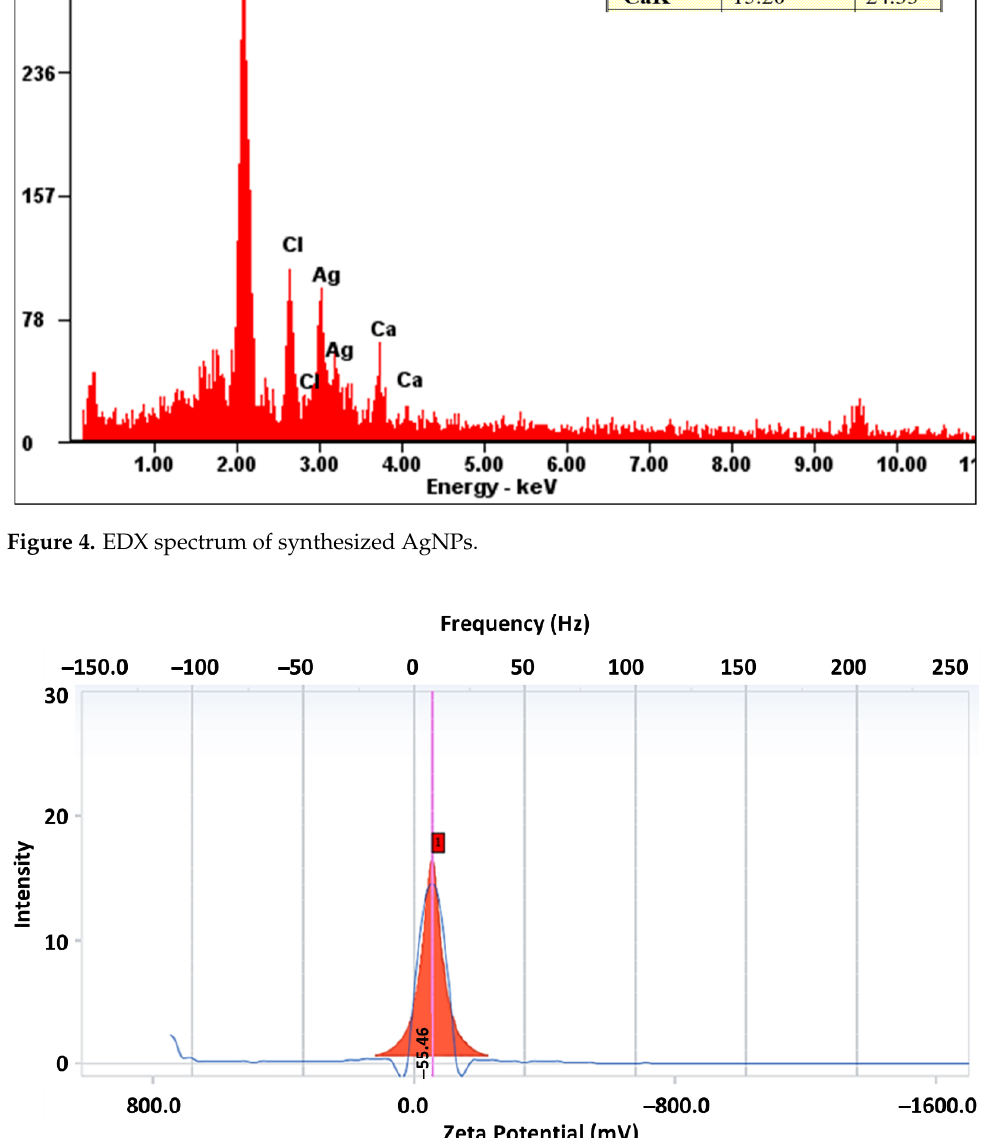
Figure 5. Zeta potential of synthesized AgNP from leaf extract of C. indica.